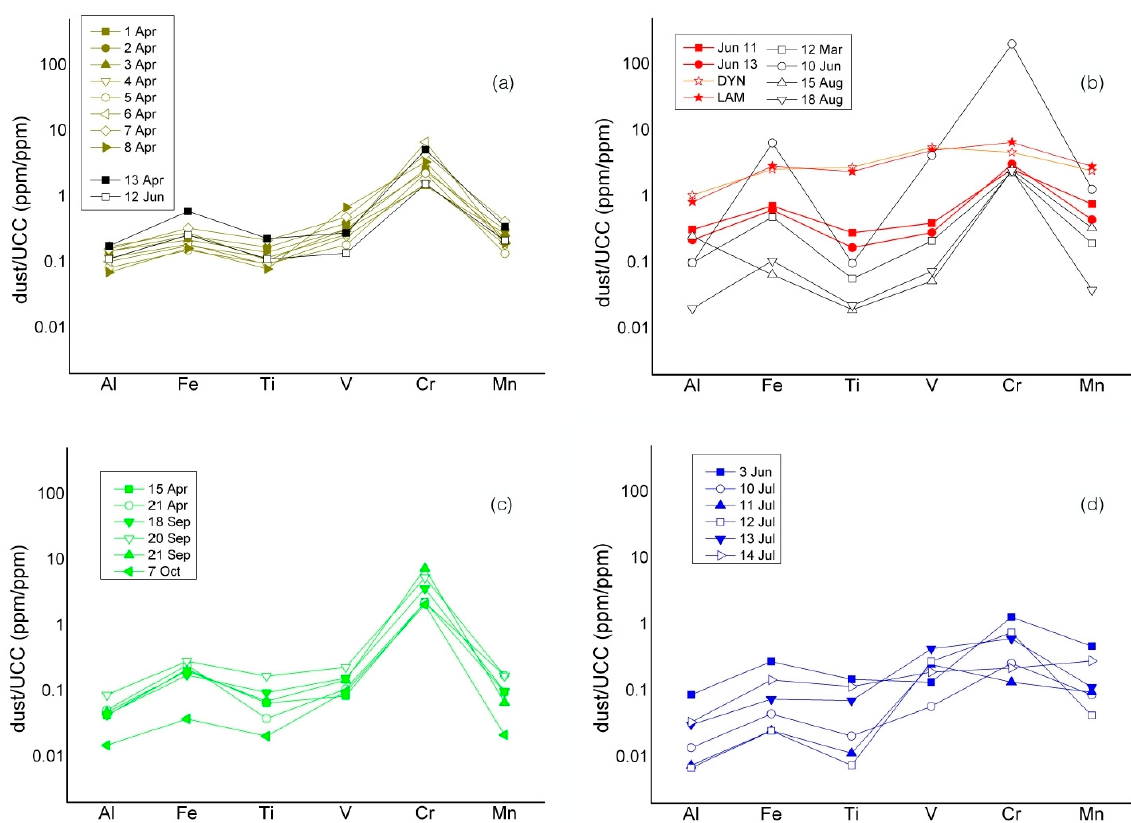
Figure 4. Metal concentrations in the daily aerosol samples from Eurasia ( a ), Iceland ( b ), Greenland ( c ), and Alaska ( d ). Data are normalized to average upper continental crust (UCC) composition (data from [35]).